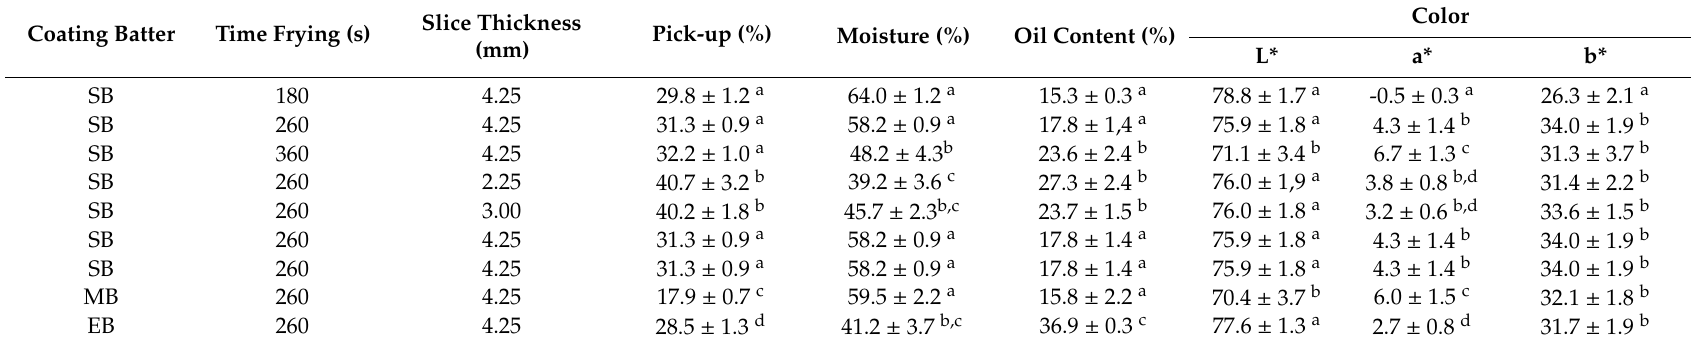
Table 3. Di ff erences in the pick-up, moisture, dry matter, final oil content and color of samples prepared with di ff erent coating batters and conditions. Coating